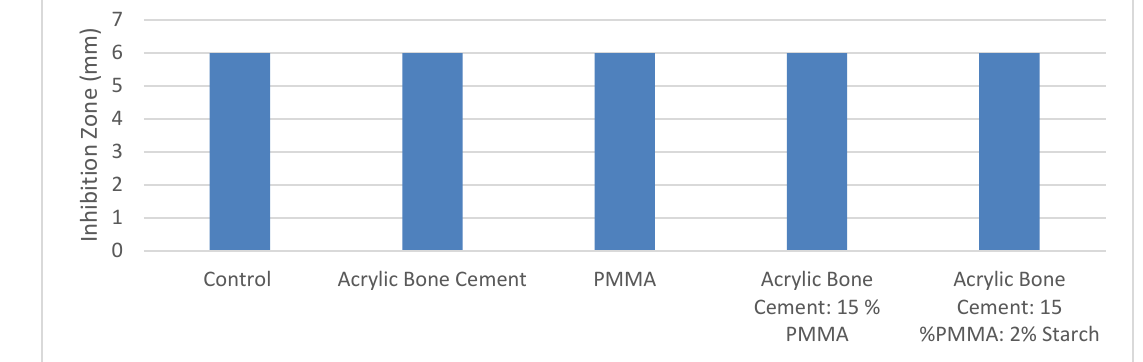
Figure, 2: Biological activity of acrylic bone cement, PMMA, (Acrylic bone cement: 15% PMMA), and (Acrylic bone cement: 15 % PMMA: 2% starch) against gram positive bacteria Baeillus subtilis (B. subtilis) . All samples were kept during incubation periods at 37 ºC for 24 hours.